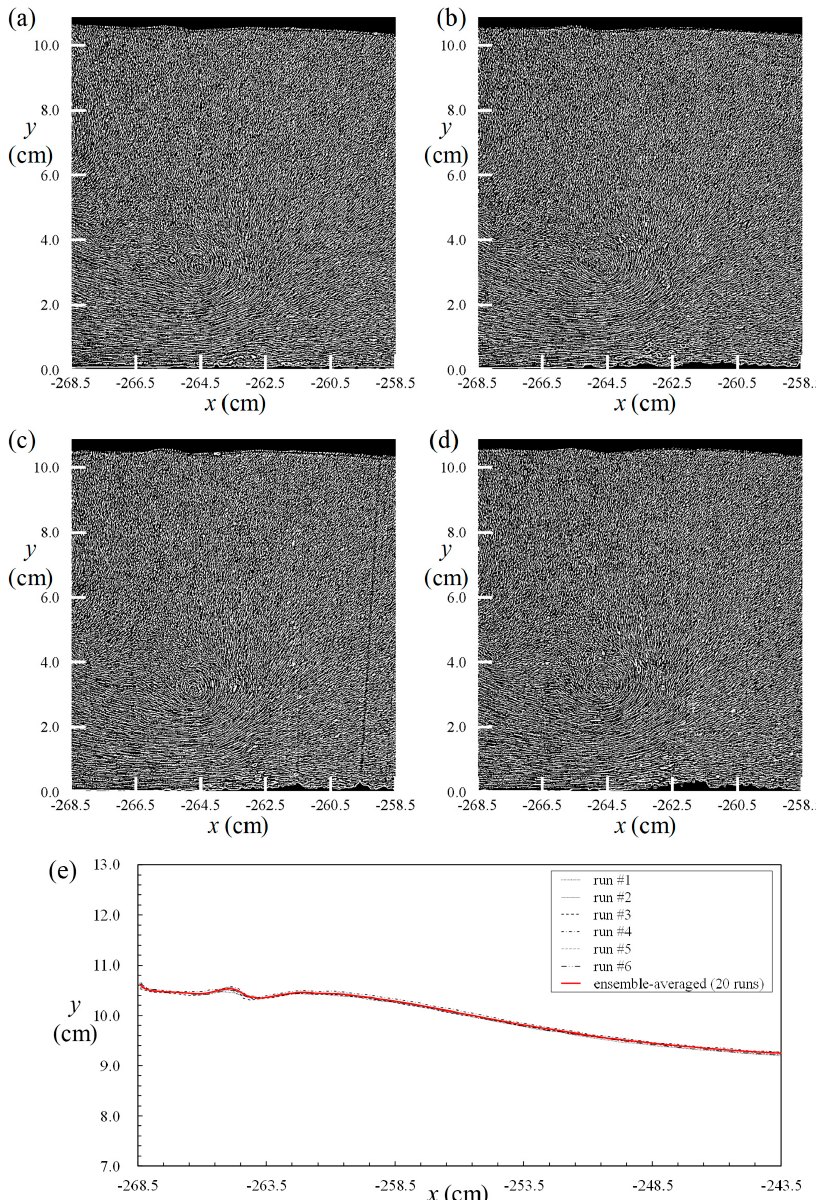
Figure 2. ( a – d ) Images taken at t ′ = 0.21 s (or t = − 2.464 s) soon after opening gate for four different repeated runs, show instantaneous flow fields underlying free surface profile right downstream of gate; ( e ) comparison of instantaneous free surface profiles among six different repeated runs and ensemble-averaged result for 20 runs.